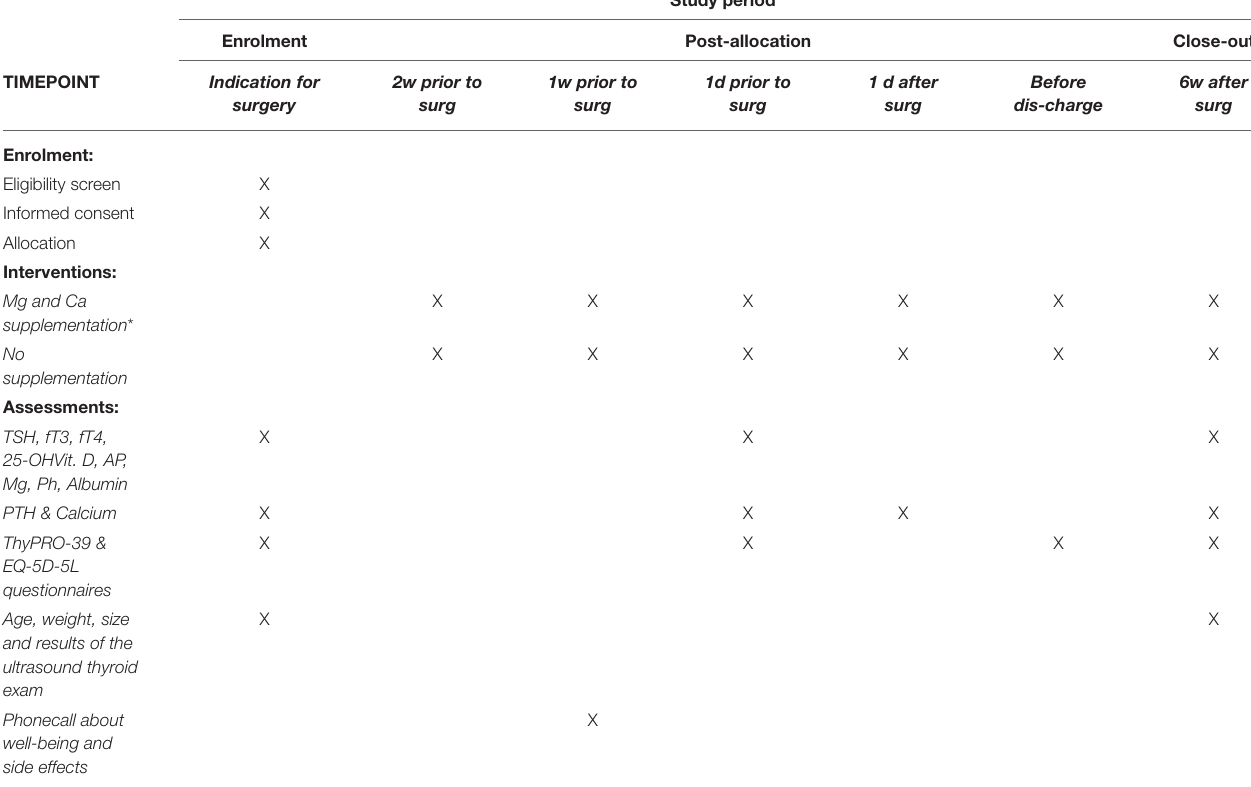
TABLE 1 | Schedule of enrolment, interventions, and assessments according to SPIRIT statement. Study period Enrolment